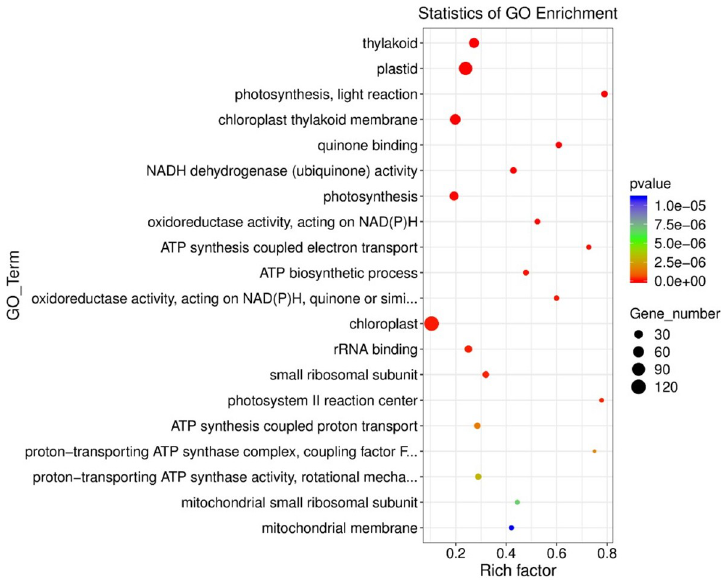
Fig 3. The GO enrichment analysis of the differentially expressed genes in maize. The horizontal axis represents the degree of enrichment (rich factor), the vertical axis represents the enriched GO term; the size of the dot represents the number of differential genes enriched in a GO term; the color of the dot represents the different p value; rich factor represents the number of differential genes belonging to a GO term/total number of genes belonging to this GO. The higher rich factor is, the higher the enrichment of